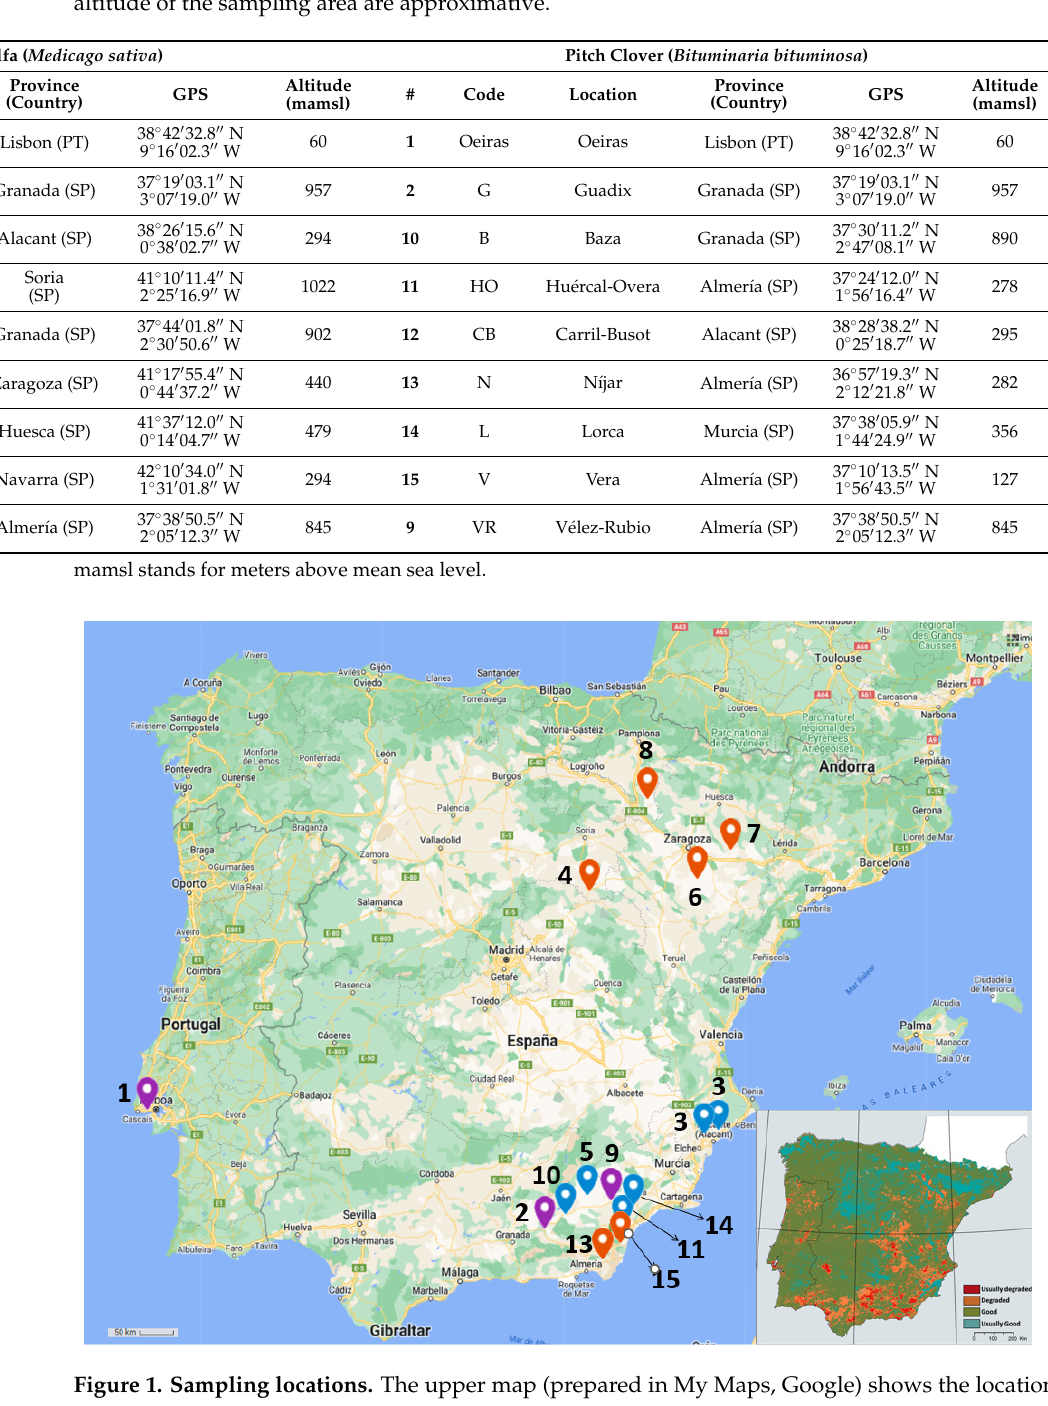
Table 1. Sampling locations. Locations are here defined by their number (for map location), code, location, province and country (where PT means Portugal, and SP, Spain). GPS coordinates and altitude of the sampling area are approximative.